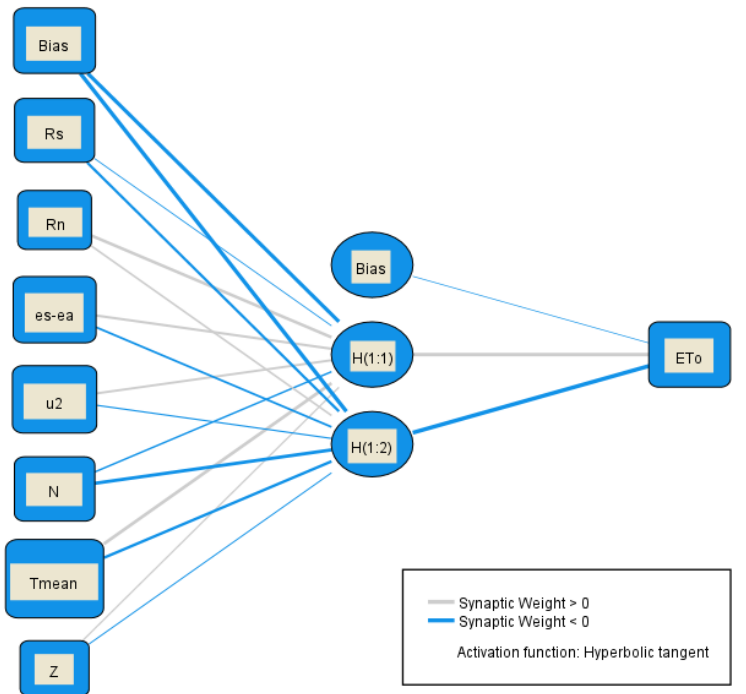
Figure 2. MLP1 model with the best performance on ETo predictions for the Peloponnese (August and December of 2016–2020).